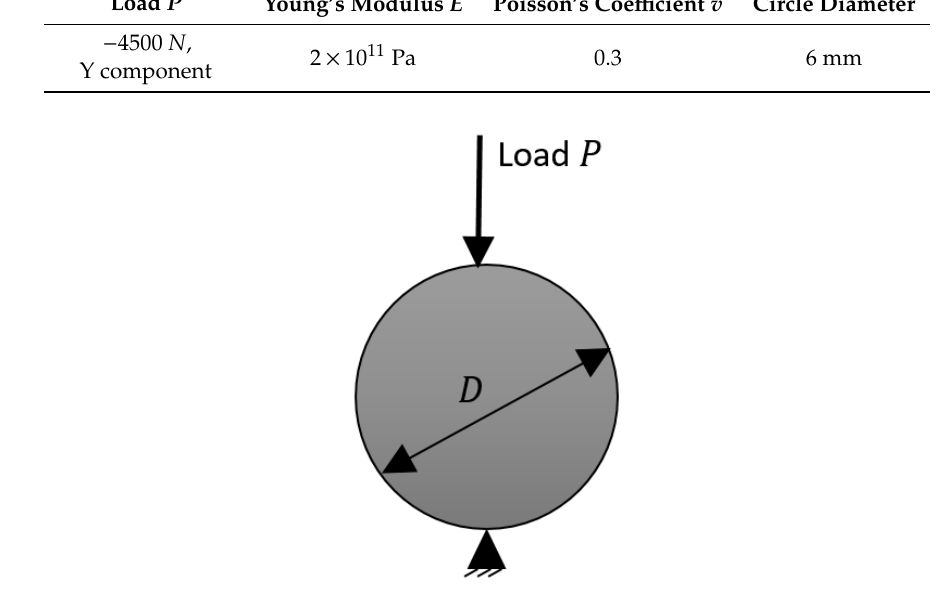
Figure 8. Cylinder under load P and a fixed point.